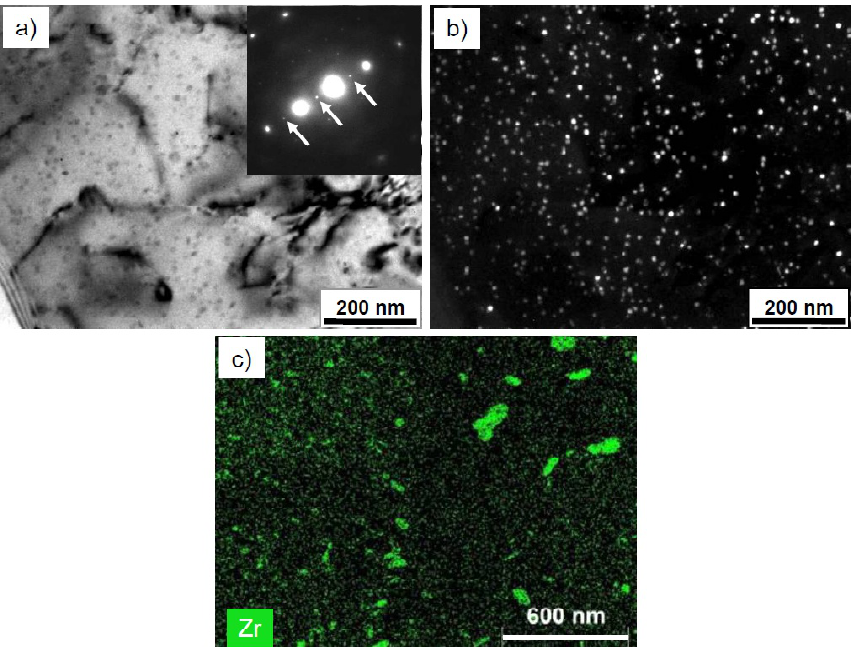
Fig. 1. Microstructure of Al–0.4Zr(wt.%) alloy after AG treatment: (a, b) – bright field and dark field TEM images of nanoscale Al Zr precipitates, the inset - corresponding SAED patterns showing superlattice 3 reflections from Al Zr precipitates ([120] zone axis), (c) – EDX map of Zr. 3